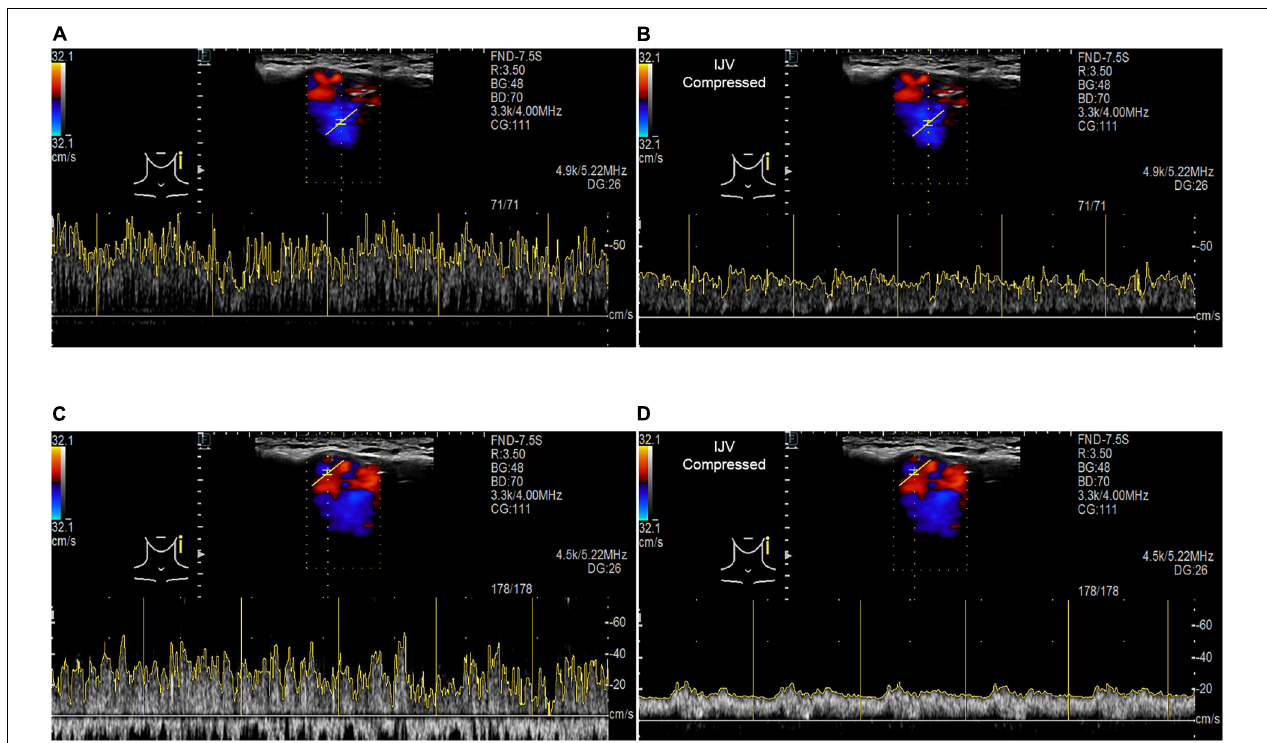
FIGURE 5 | RCCD and IJV compression examination of the association between PT and transverse–sigmoid junction hemodynamics. IJV indicates the internal jugular vein. The yellow vertical lines indicate the RR intervals of the electrocardiogram. (A) Real-time mainstream sinus flow velocity spectrum before IJV compression. (B) Real-time mainstream sinus flow velocity spectrum during IJV compression. (C) Real-time diverticular flow velocity spectrum before IJV compression. (D) Real-time diverticular flow velocity spectrum during IJV compression.